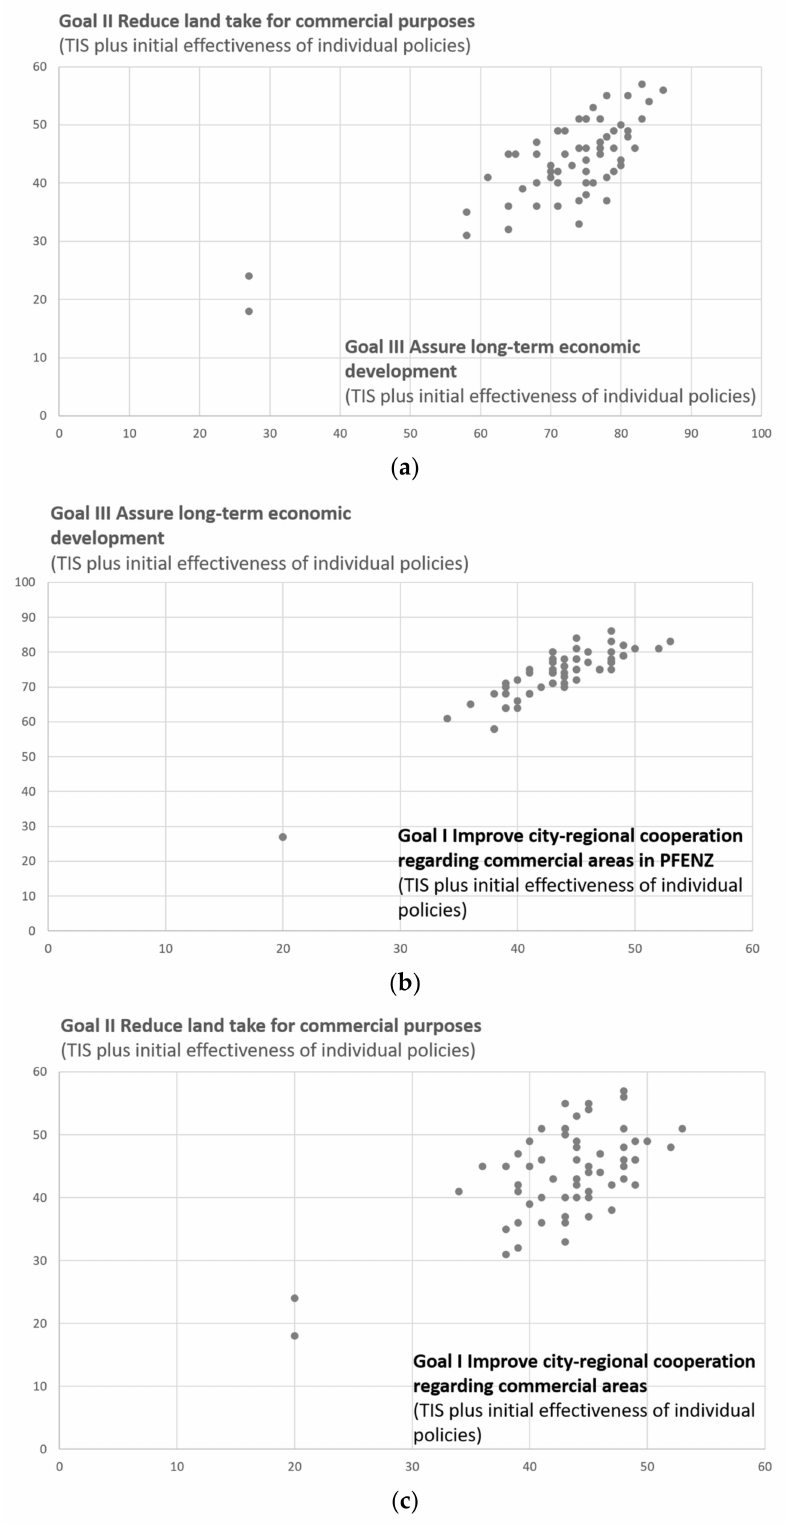
Figure 6. Relation of the overall objectives to each other in the n = 60 consistent policy mixes (goal attainment calculated by (double) initial effectiveness of the individual measures plus Total Impact Score TIS): ( a ) goal II and goal III; ( b ) goal III and goal I; ( c ) goal II and goal